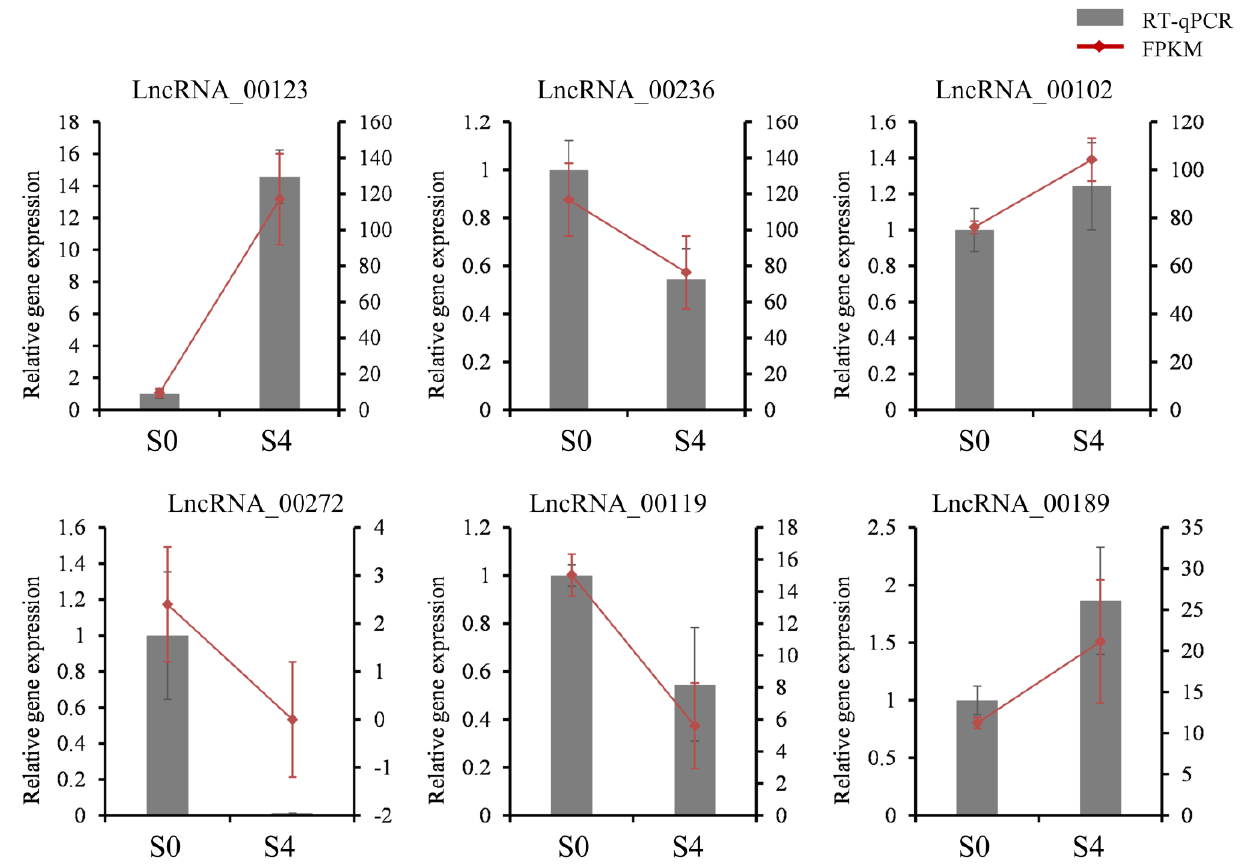
Figure 6. Relative expression analysis of select lncRNAs using quantitative real time polymerase